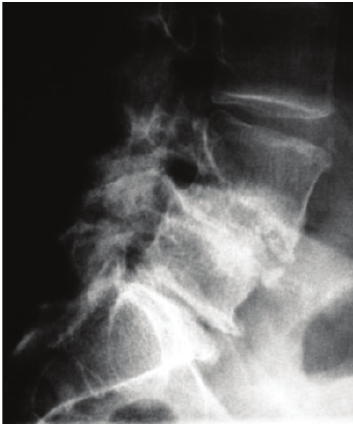
Figure 5: Lateral radiograph shows destruction of L4-L5 vertebral bodies producing multiple bony fragments (Case